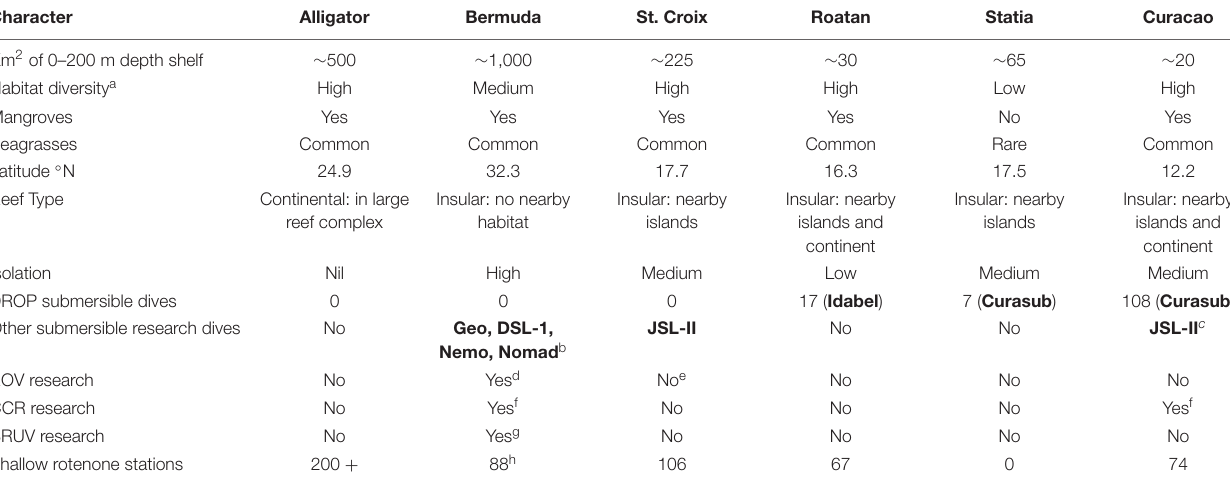
TABLE 1 | Characteristics of the six study sites and research activities on deep-reef fishes at each.